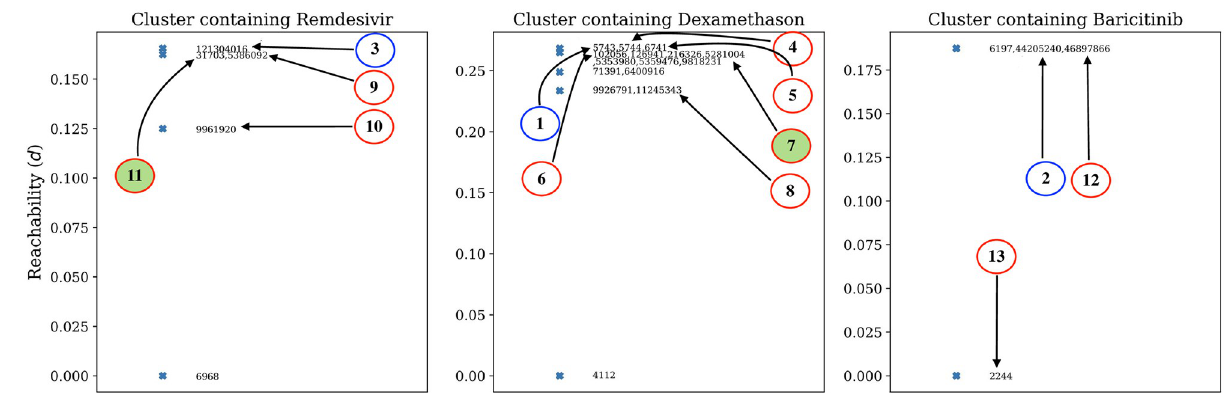
Fig 6. Reachability plot of three different clusters associated with the reference drugs obtained from OPTICS analysis. The occurrence of the reference drugs, similar drugs and the best two candidate drugs in the reachability plot are highlighted in a similar manner as that of Fig 5.